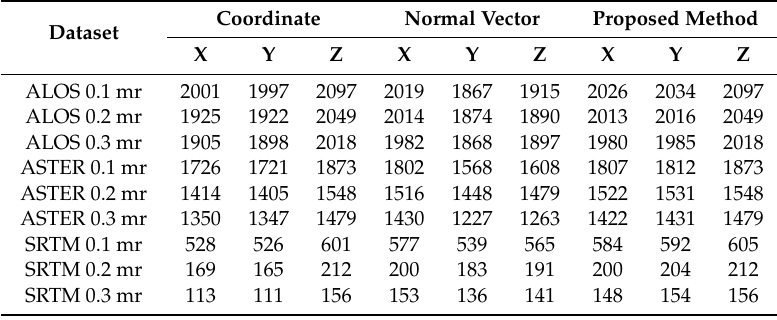
Table 4. Direction consistency of three LRF construction